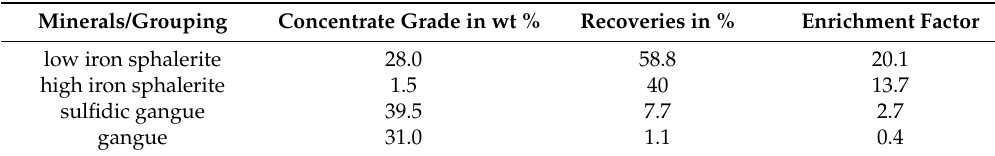
Table 10. Grade, recoveries and enrichment factor for